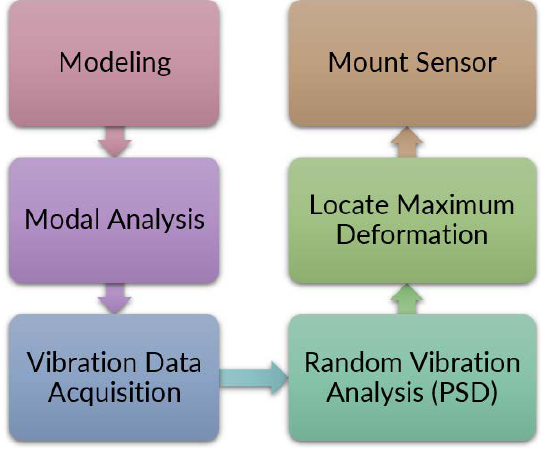
Figure 2. FEM architecture.